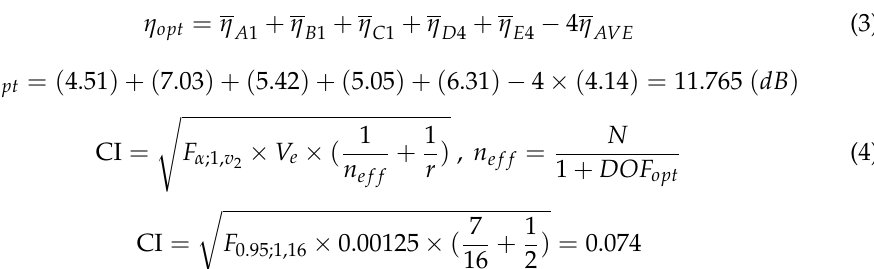
Table 9. A comparison of the experimental verification of deformation and the predicted value. Exp. N1 N2 Optimal 0.267 0.254 0.261 0.007 11.697 11.765 ±